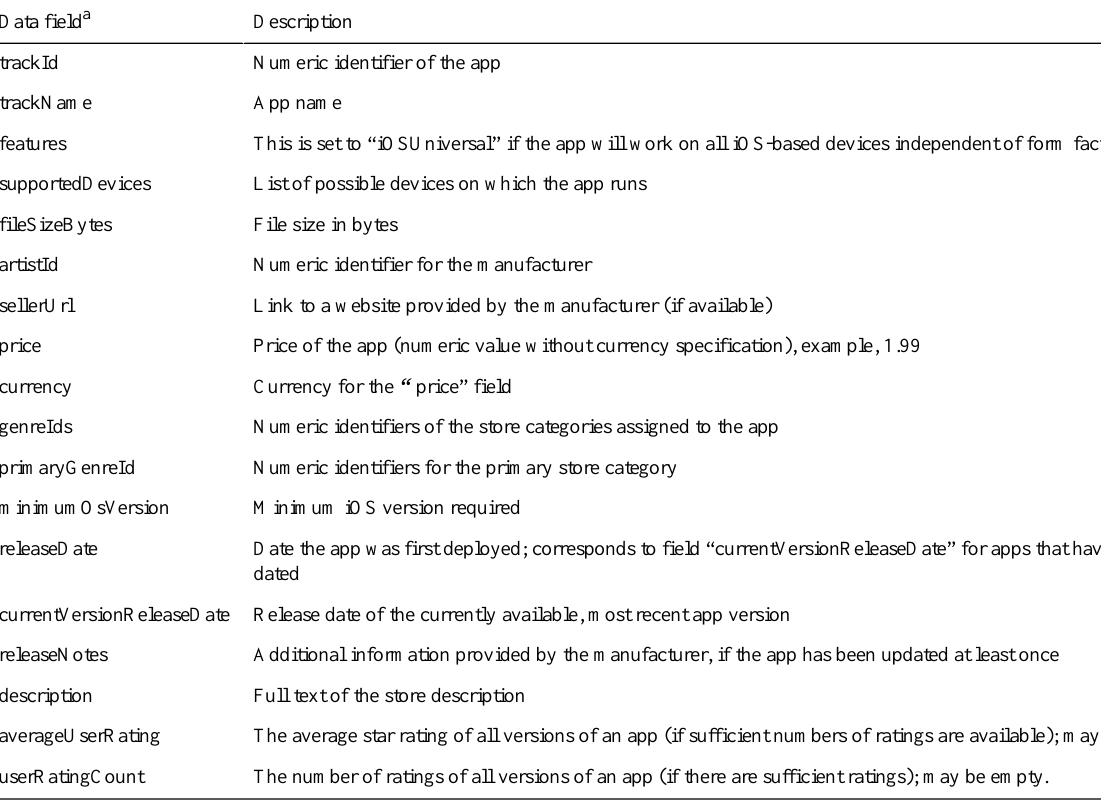
Table 1. Metadata fields provided by Apple with relevance to our